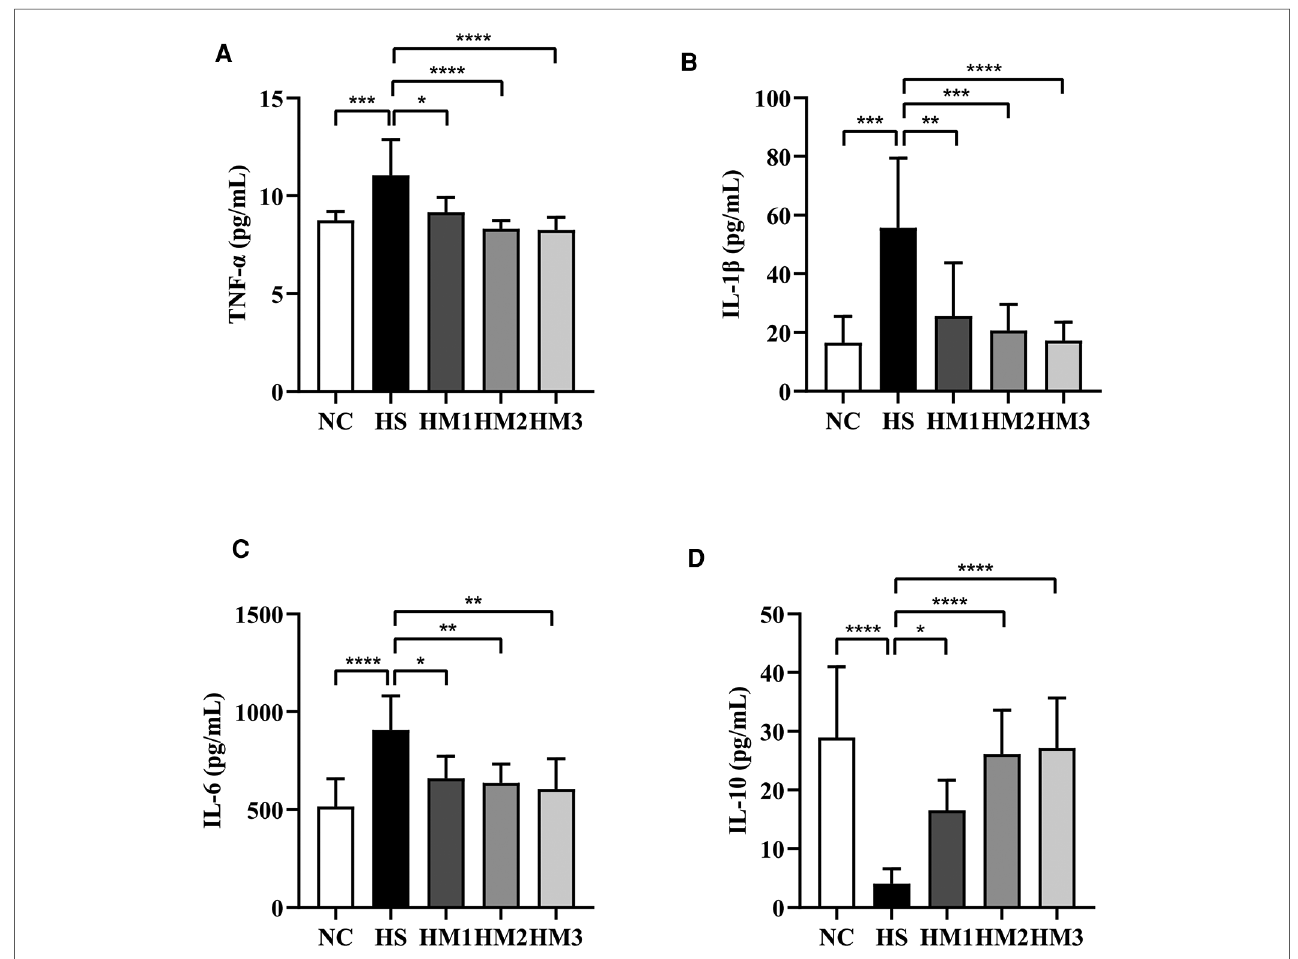
FIGURE 7 Human umbilical cord-derived mesenchymal stem cells (hUC-MSCs) reduces proin fl ammatory cytokine levels and increases anti-in fl ammatory cytokine level in rat pups. The rat pups reared in the HS group showed signi fi cantly higher levels of IL-1 β , IL-6, and TNF- α and lower level of IL-10 than did those reared in the